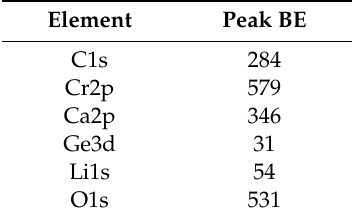
Figure 12. X-ray photoelectron spectroscopy (XPS) survey spectra of the Li 2 CaGe 0.95 Cr 0.05 O 4 crystal. Table 2. The peak banding energy of the elements of the Li 2 Ca 0.95 Cr 0.05 GeO 4 crystals. Element Peak BE Element Peak BE C1s